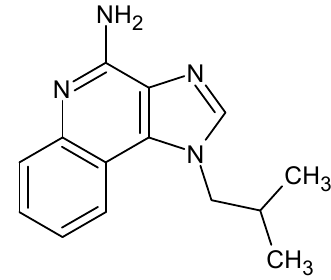
Scheme 1. Imiquimod chemical